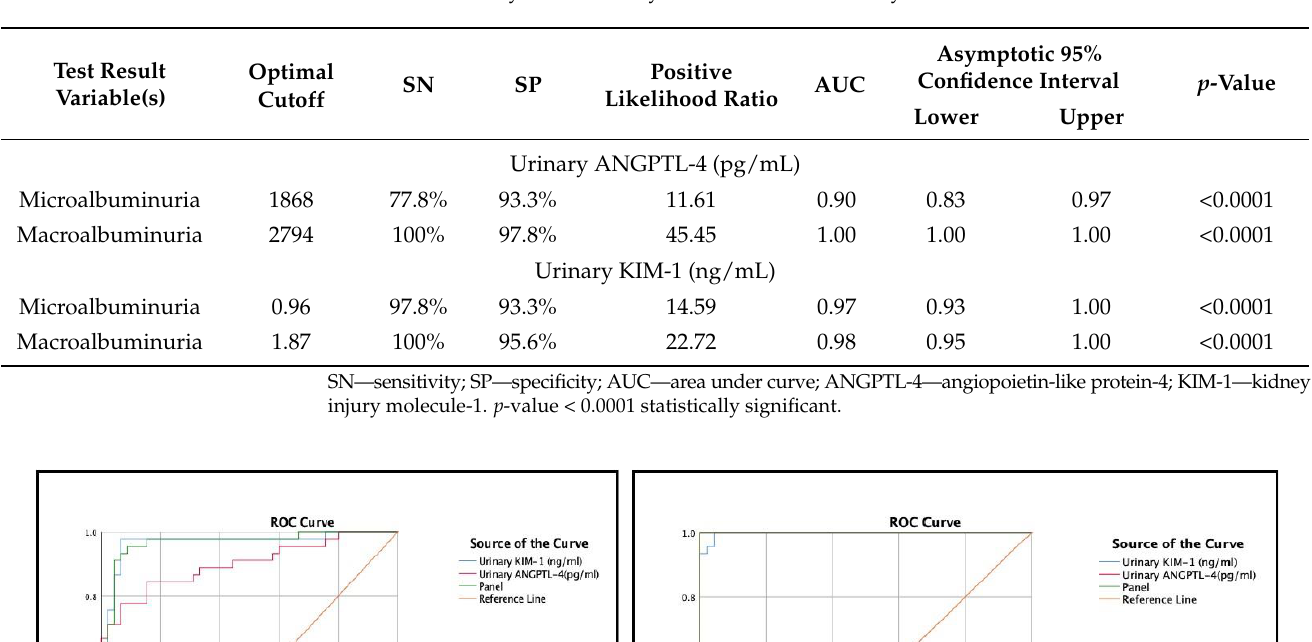
Table 4. ROC analysis for urinary ANGPTL-4 and urinary KIM-1.